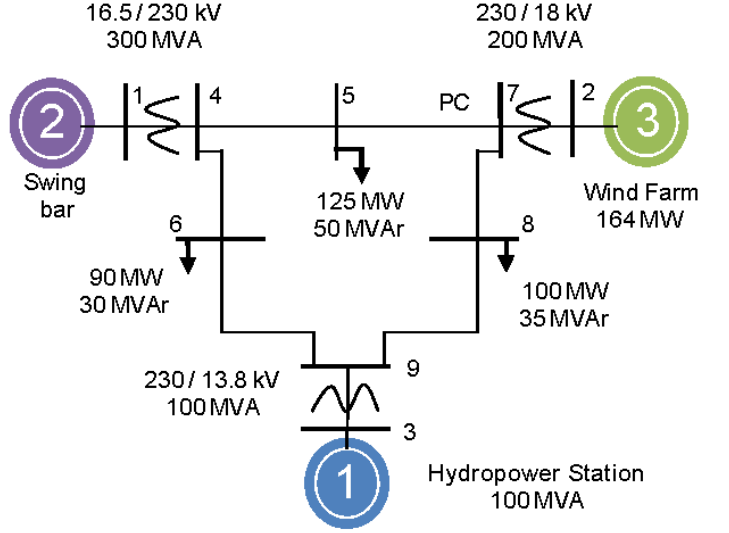
Figure 2. Single-line diagram of the test